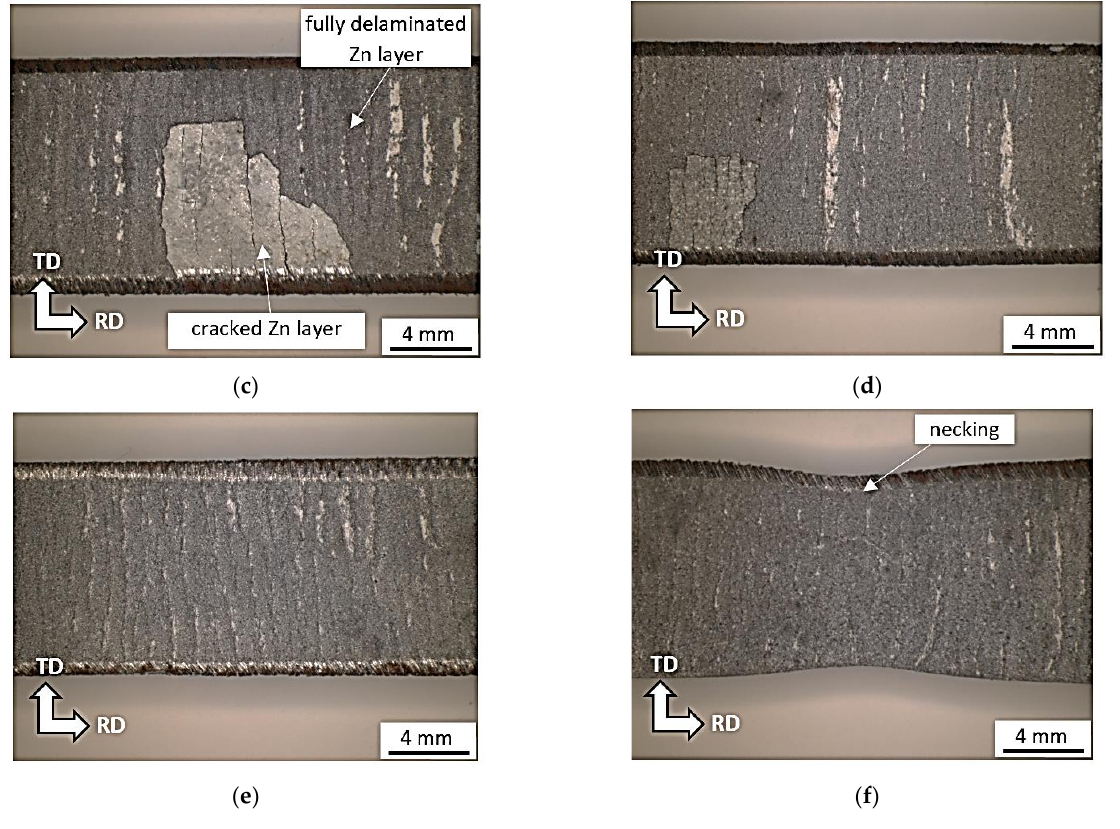
Figure 12. Delamination of the Zn layer during tensile test as a function of plastic strain for strain rate 0.5 × 10 −3 s −1 , RD-TD views. ( a ) bulk, ( b ) ε = 5.0%, ( c ) ε = 11.8%, ( d ) ε = 18.7%, ( e ) ε = 36.5%, ( f ) ε = 32.5%.